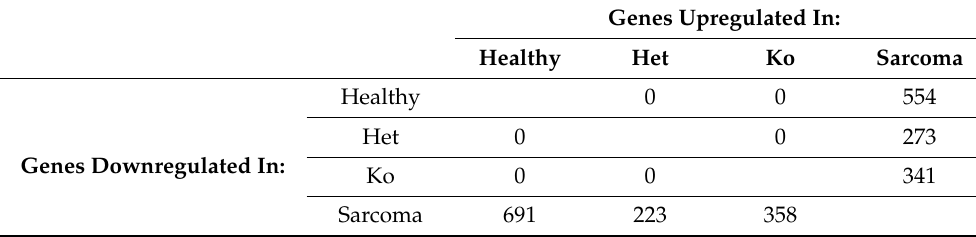
Genes Downregulated In: